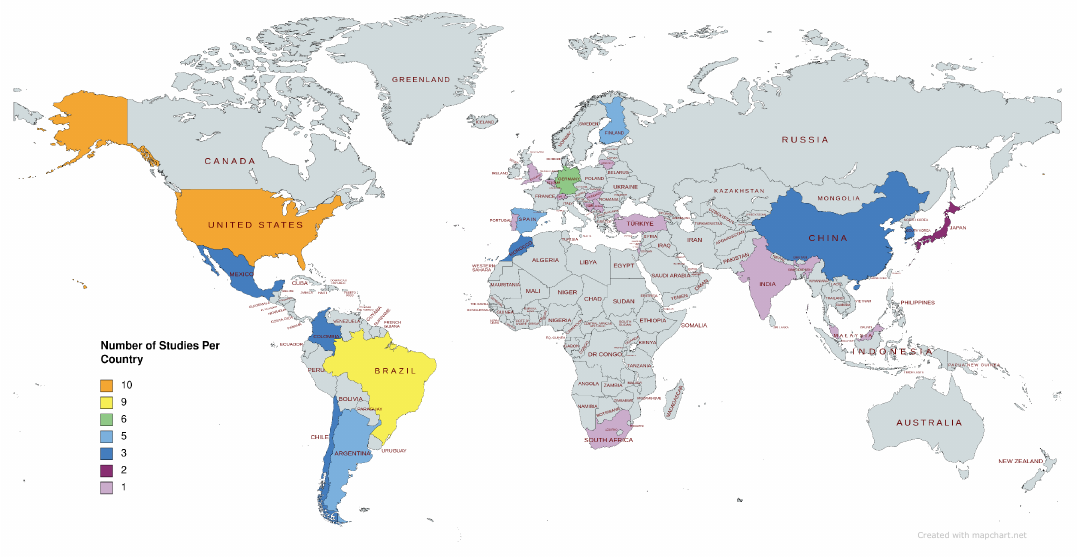
Figure 2. Topographic map of the world with studies